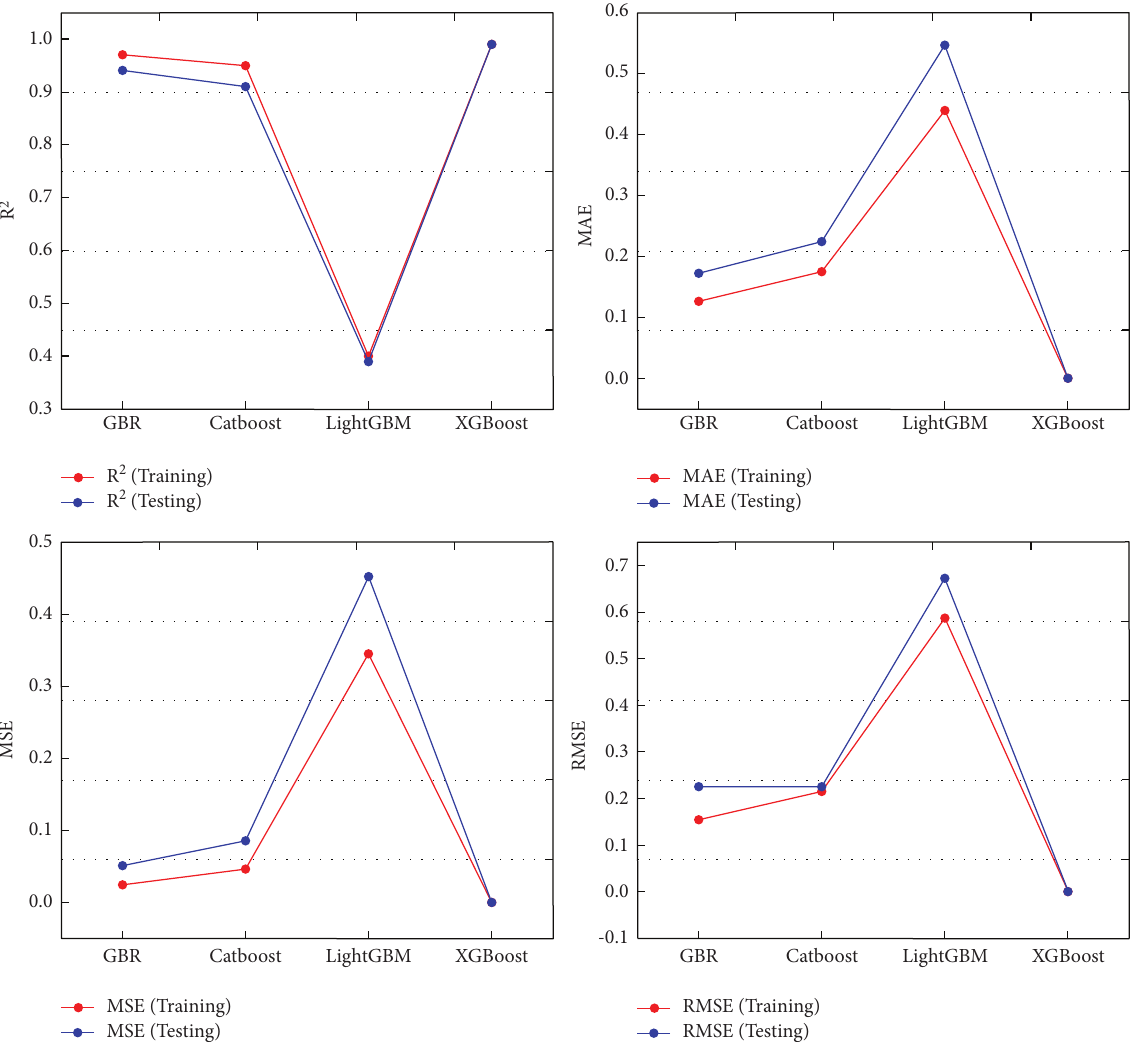
Figure 13: Evaluation criteria of the proposed algorithms R 2 , MAE, MSE, and RMSE in the training phase and testing phase, respectively.